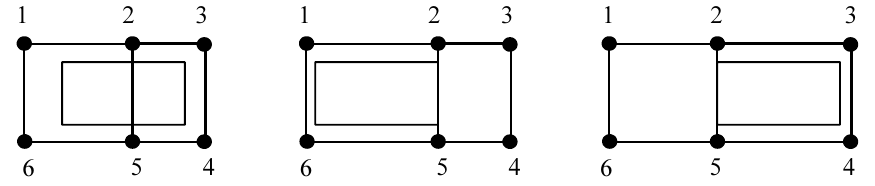
Figure 8. A label that belongs to edge (2, 5) could be placed on either side of the